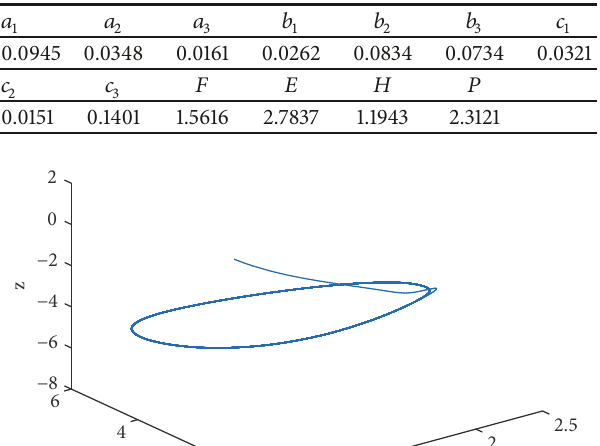
Table 2: Identifying the actual parameters of system (1) by identify- ing the actual data.